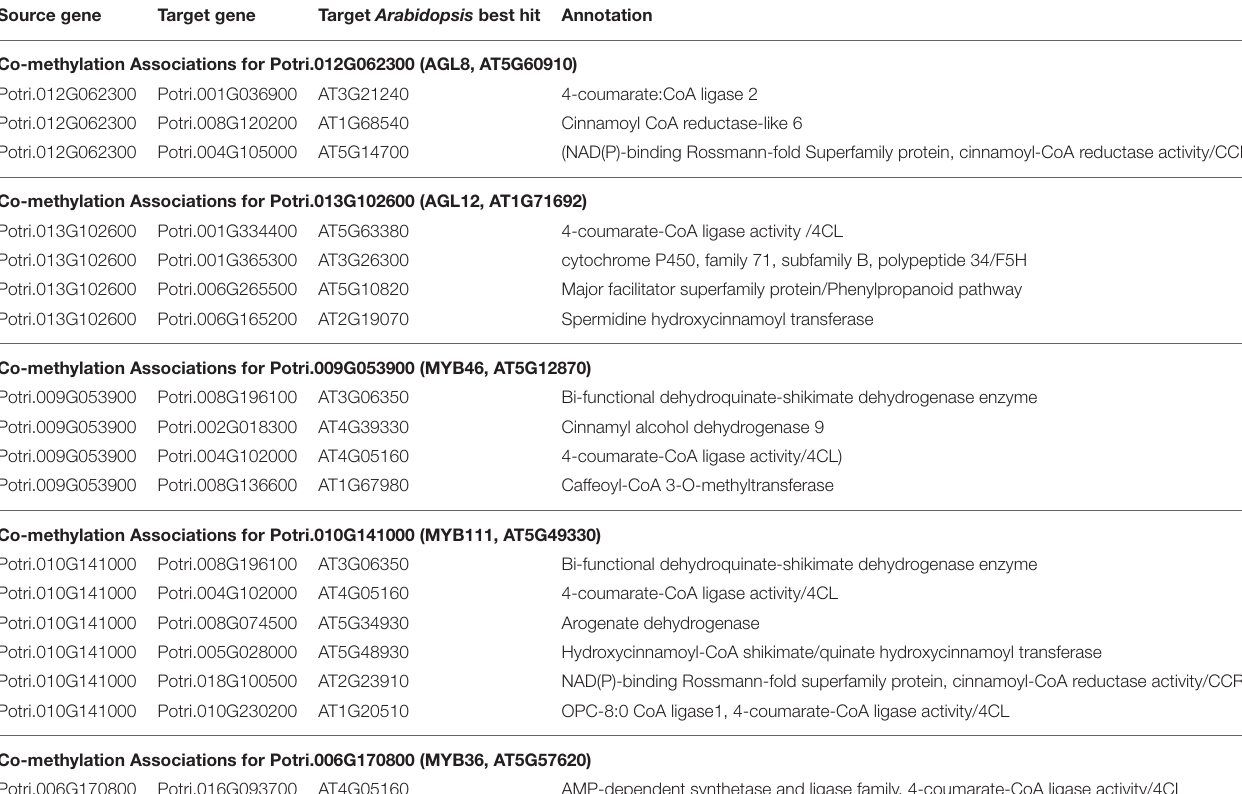
TABLE 3 | Co-methylation associations for select new potential target genes. Annotations are derived from best Arabidopsis hit descriptions and GO terms and in some cases MapMan annotations. Source